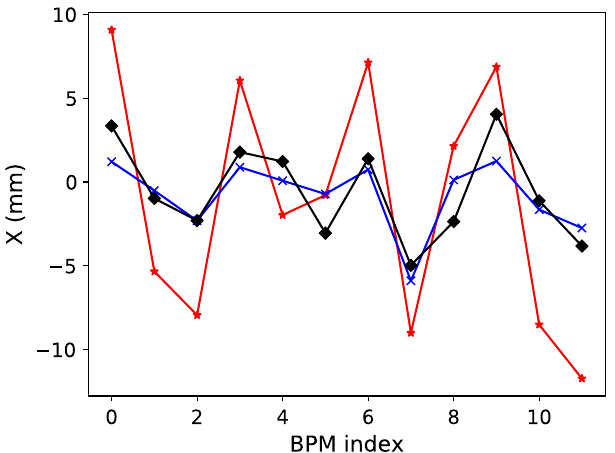
synchrotron.FIG. 3. Measured closed orbits in the x plane of SIS18. Red line (star): Perturbed orbit (rms ¼ 7 . 12 mm). Blue line (times): Corrected orbit using original ORM (rms ¼ 2 . 15 mm). Black line (diamond): Corrected orbit using nearest-circulant approxi- mation (rms ¼ 2 . 82 mm).